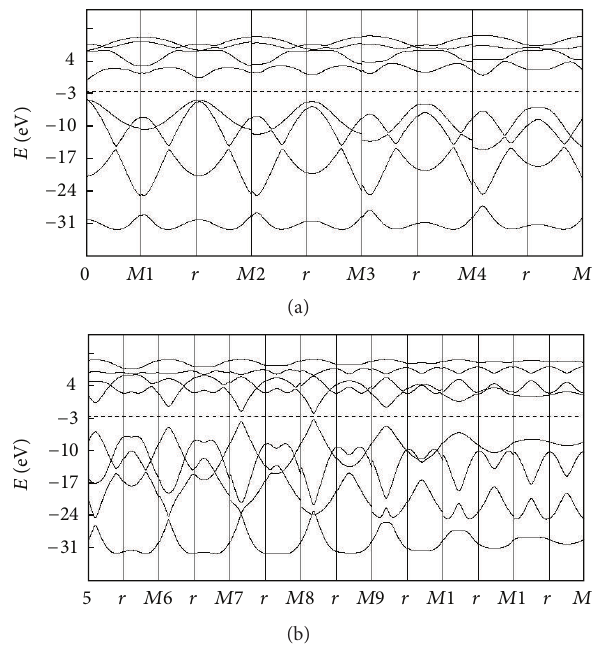
Figure 9: Band structure of [(23,5),91] SWSiNT for full set of allowed k 𝜙 , that is, [(−𝑟/23, 1/2) → (−𝑟/23, 0) | (𝑟/23, 0) → (𝑟/23, 1/2)] , with arrangements (a) 𝑟 = 0 , 𝑟 = ±1, ±2,±3, ±4 and (b) 𝑟 = ±5,±6, ...,±11 .